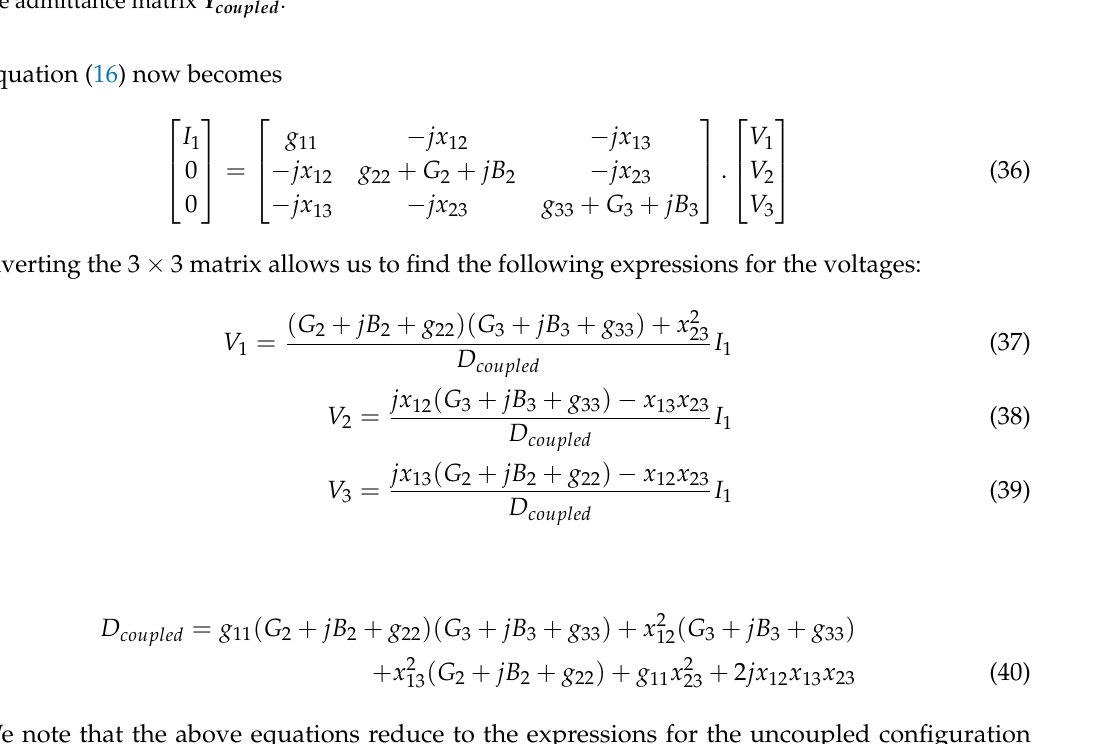
Figure 3. Schematic overview of a capacitive wireless power transfer (CWPT) system with one transmitter and two receivers, where we have added the susceptances B 2 and B 3 to compensate for the coupling between C 2 and C 3 . The dashed rectangle indicates the three-port network characterized by the admittance matrix Y coupled